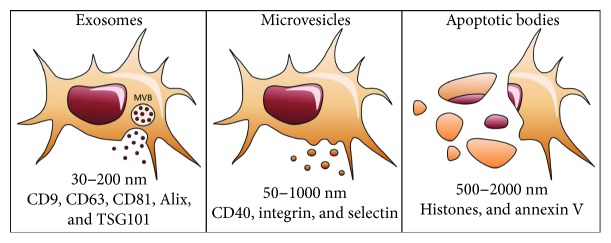
Types of extracellular vesicles and their identifying characteristics. Exosomes, with diameters ranging from 30 to 200 nm, are formed by the inward budding of multivesicular bodies (MVBs), which then fuse with the plasma membrane to be released into the extracellular environment. Exosomes are classified by tetraspanins CD9, CD63, and CD81 and the proteins Alix and TSG101 involved in MVB biogenesis. Microvesicles, also referred to as ectosomes, are larger with diameters from 50 to 1000 nm and bud directly from the plasma membrane. Microvesicles encompass identifying markers CD40, integrin, and selectin. Apoptotic bodies range from 500 to 2000 nm and encompass fragments of dead or dying cells. These are characterized by the presence of histones and annexin V.